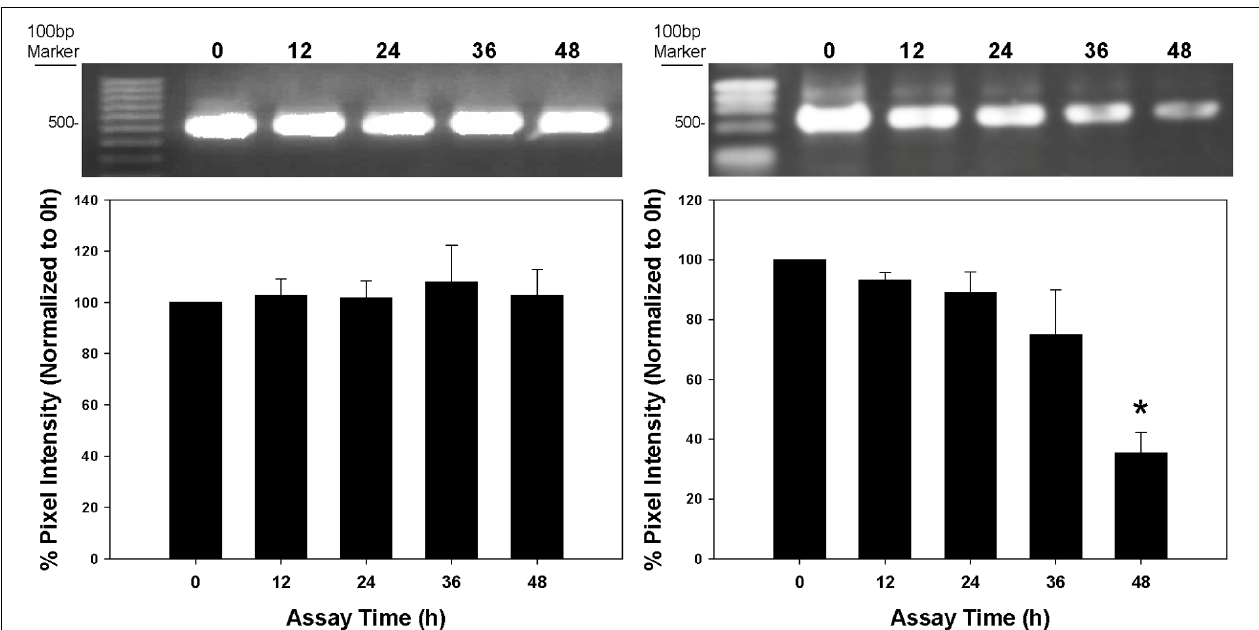
FIGURE 3 | dsRNA stability in the presence and absence of S. curviseta . Left : without S. curviseta, v-ATPase A dsRNA incorporated into the diets was stable throughout 2-days assay period [H(4) = 7.5462, P = –0.109]. Right: in the presence of S. curviseta, however, v-ATPase A dsRNA started to degrade at the end of the 2-days assay [H(4) = 14.230, P = 0.007]. Values shown are percentages (% pixel intensity of the v-ATPase A dsRNA gel band) ± SE. Asterisk ( ∗ ) means v-ATPase A dsRNAs was stable for the first 36 h in the presence of S. curiviseta , while it started to degrade by 48